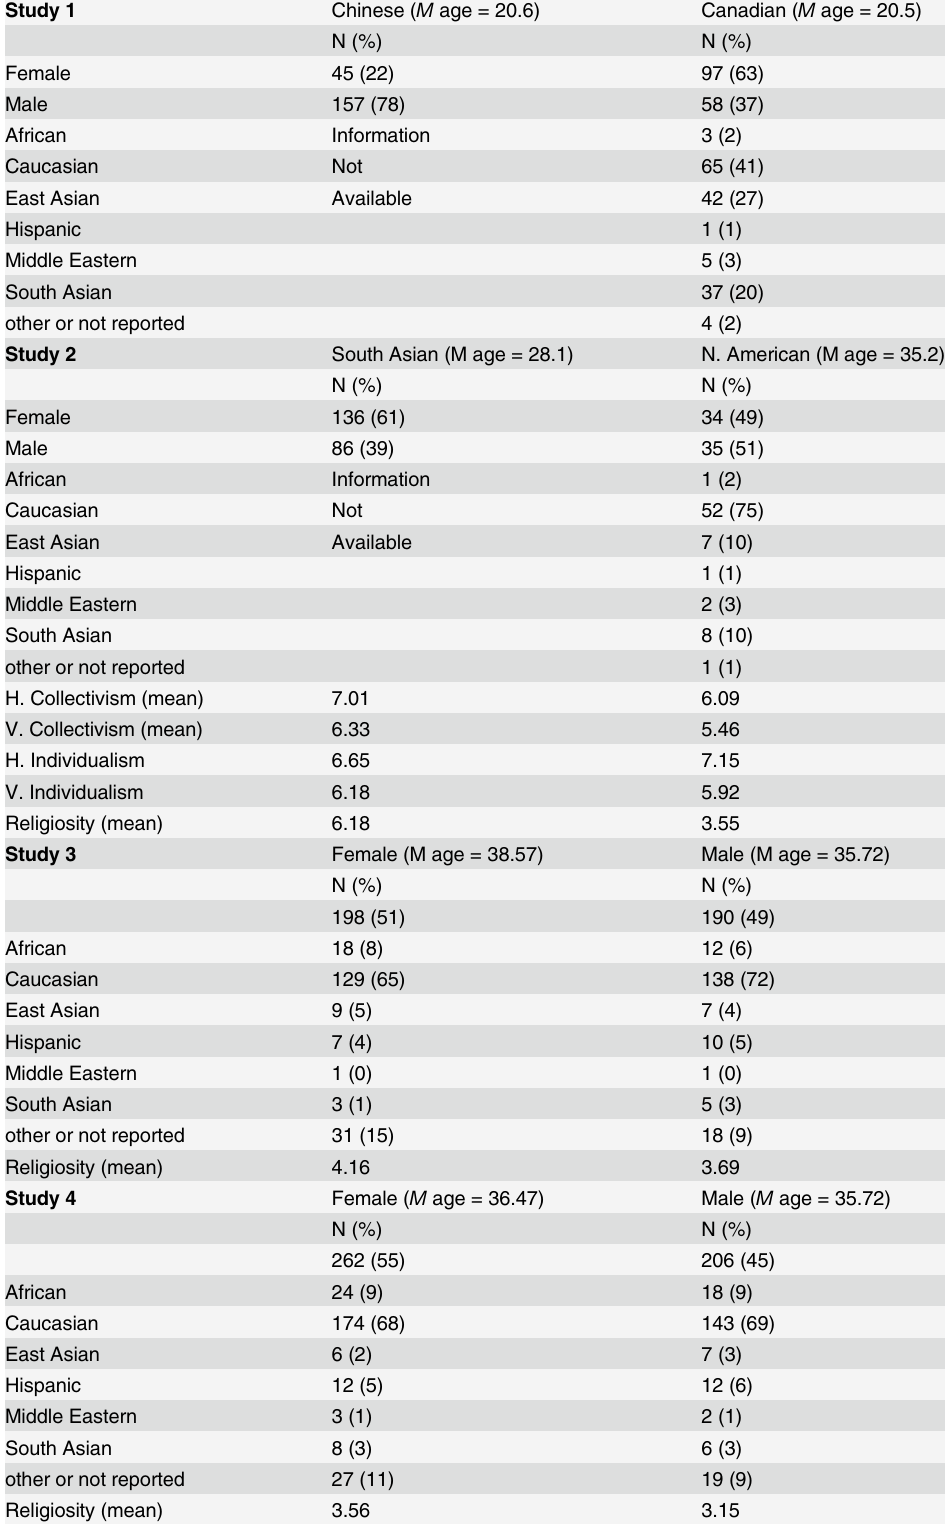
Table 1. Demographic data in all